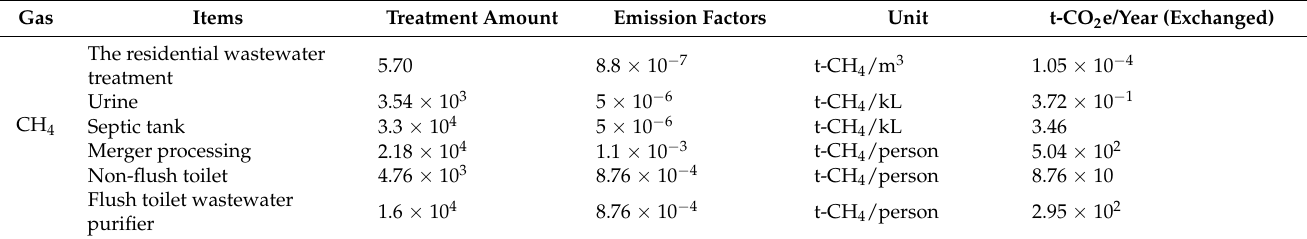
Table 7. Emission factors of CH 4 and N 2